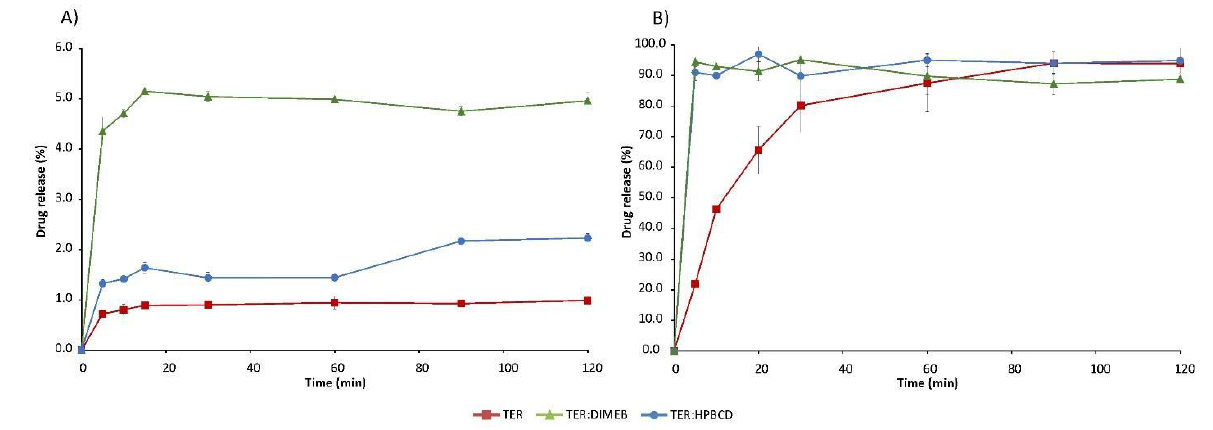
Figure 13. In vitro dissolution studies of TER and products in simulated intestinal fluid ( A ) and simulated gastric fluid ( B ). Table 1. DE and MDT values with standard deviation in simulated intestinal and gastric media.